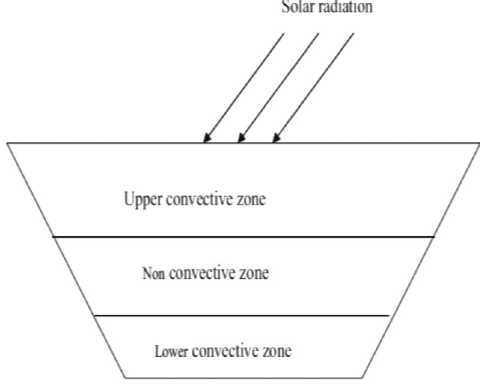
Fig. 2. Salt gradient of solar pond (El-Sebaii et